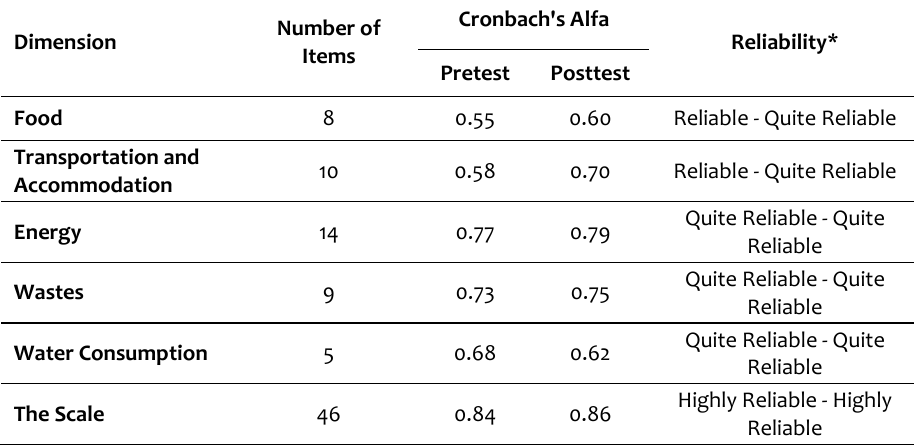
Table 2. Reliability calculation of the